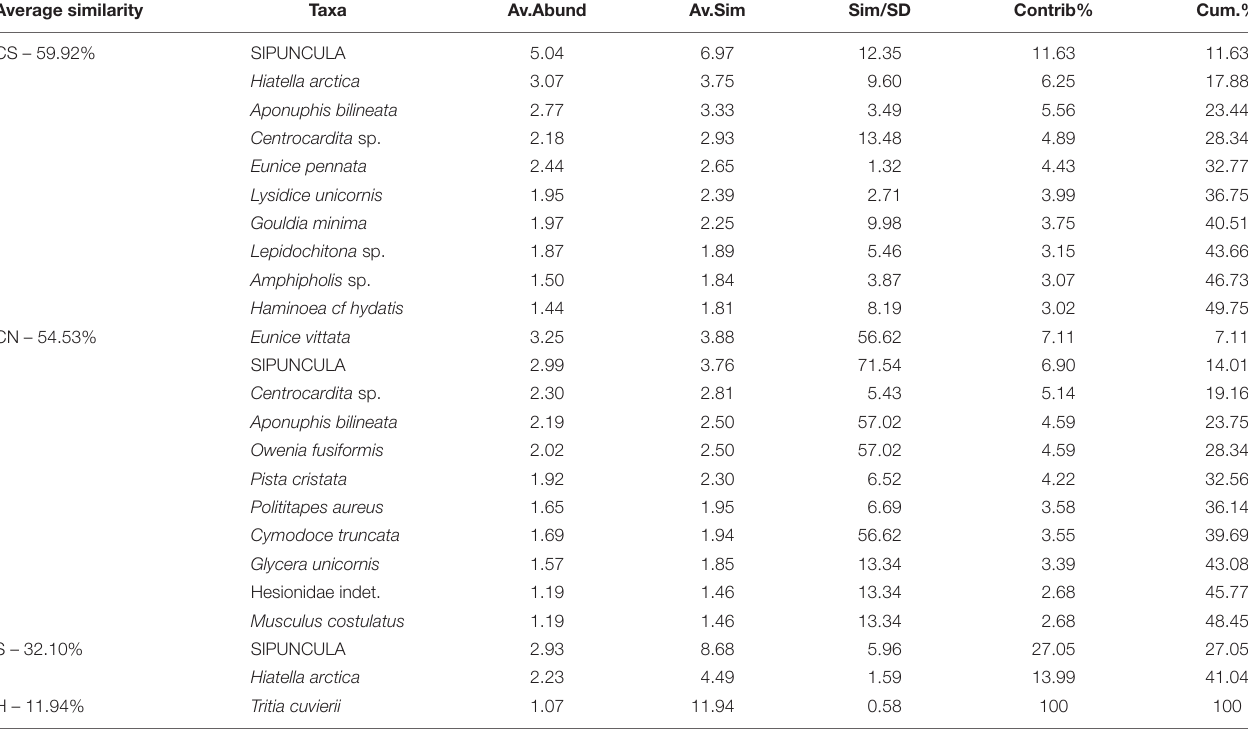
TABLE 6 | Results of similarity of percentages test, showing dominant species mostly responsible for the similarity among replicates for each site (Cum%-50% cut-off). Average similarity